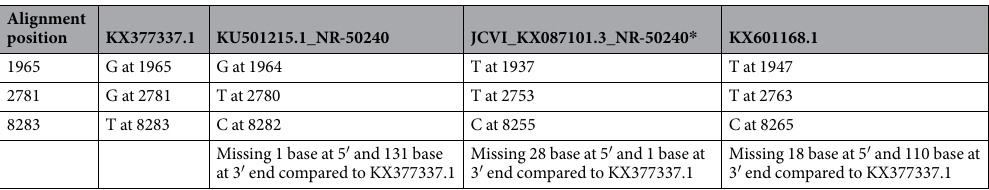
Table 3. Consensus substitutions in different PRI/PRVABC59/2015 sequences, with numbers representing the nucleotide position in the genome for each sequence. * Sequenced at JCVI as part of the current work.